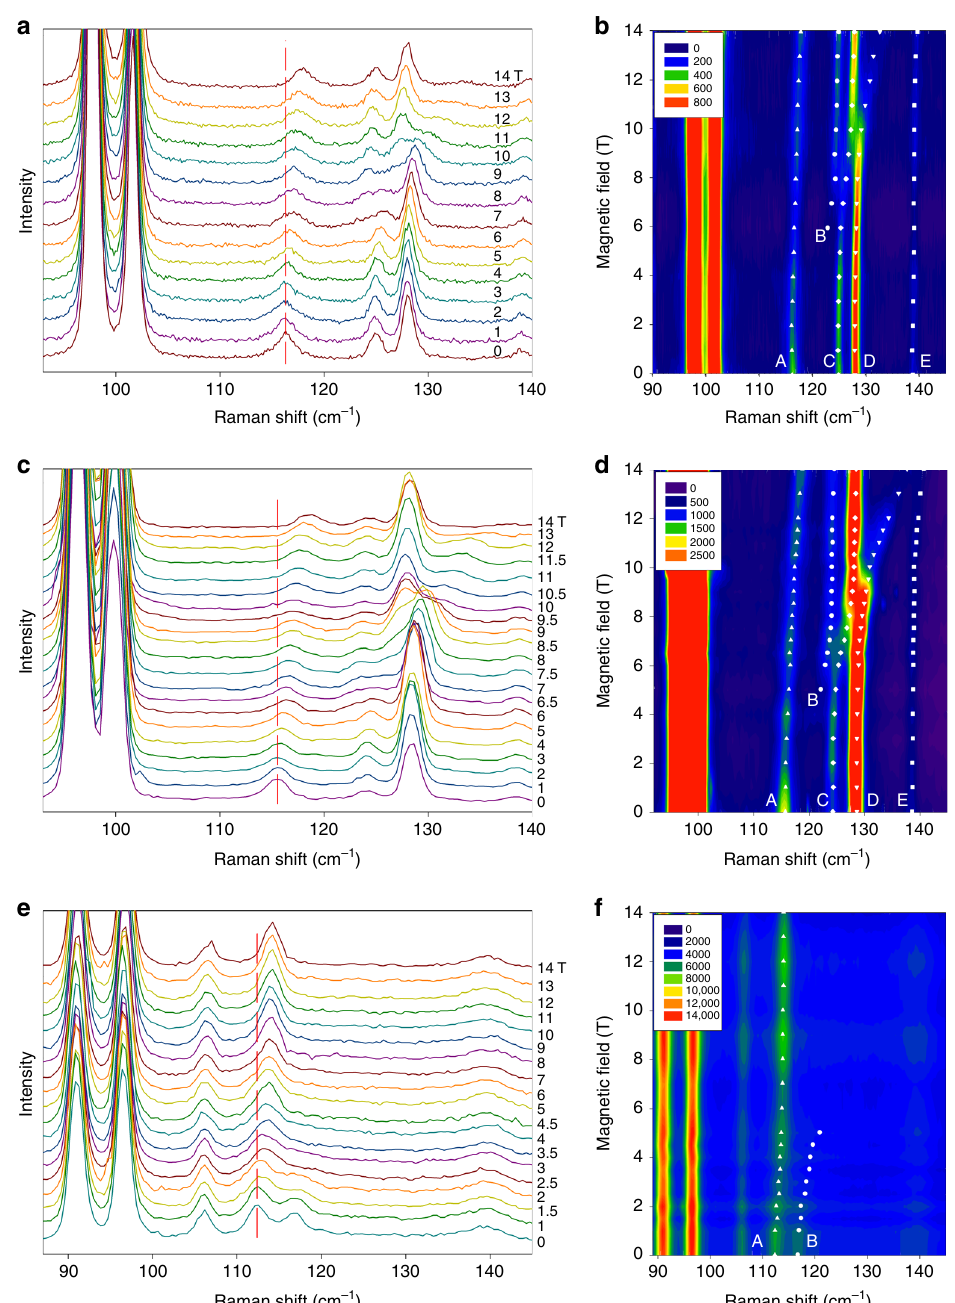
Fig. 2 Raman spectra and contour maps in 0 – 14 T magnetic fi elds. a , b 1 , c , d 1- d 4 and e , f 1- d 18 . Vertical lines indicate Peak A as one spin – phonon coupled peak in each set of spectra. The contour maps more clearly show the avoided crossings as a result of the spin – phonon couplings. The color codes in b , d , f are in units of counts. Raman spectra of 1 were collected up to 18 T but were trimmed to be consistent with other data